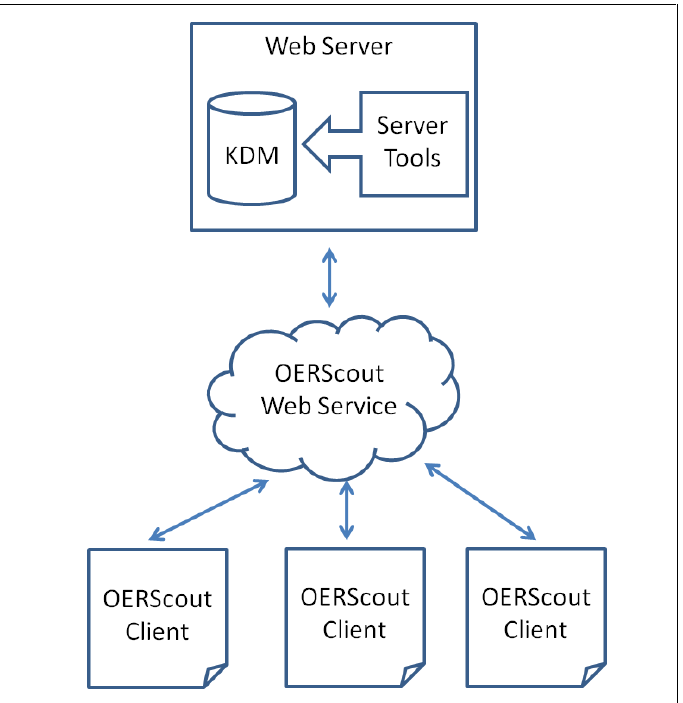
Figure 5. OERScout deployment architecture which has a web server hosting the KDM, a web service for accessing the KDM, and a Microsoft Windows based client